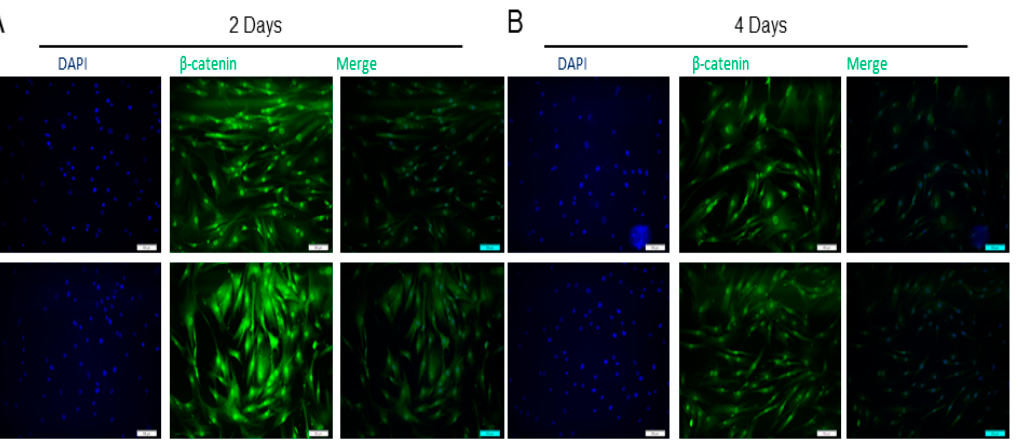
Figure 7. Fd-ECM induces chondrogenic differentiation in ad-MSCs. Ad-MSCs were cultured on plastic dishes ( − ) or on the fd-ECM (+) for the indicated days ( A – C ) Immunoblot analysis of Sox9, Notch1, β -catenin, Runx2, Gata3, Osteopontin, p -TGF β RII, and Jagged1 in ad-MSCs lysates after two, four, and eight days of incubation on plastic dishes and on the matrix; ( D – F ) RT-qPCR was used to analyze the levels of SOX9 , NOTCH1 , RUNX2 , GATA3 , OSTEOPONTIN , TNF- α , and HES1 in ad-MSCs mRNA after two, four, and eight days of incubation on plastic dishes and on fd-ECM. * p < 0.05.